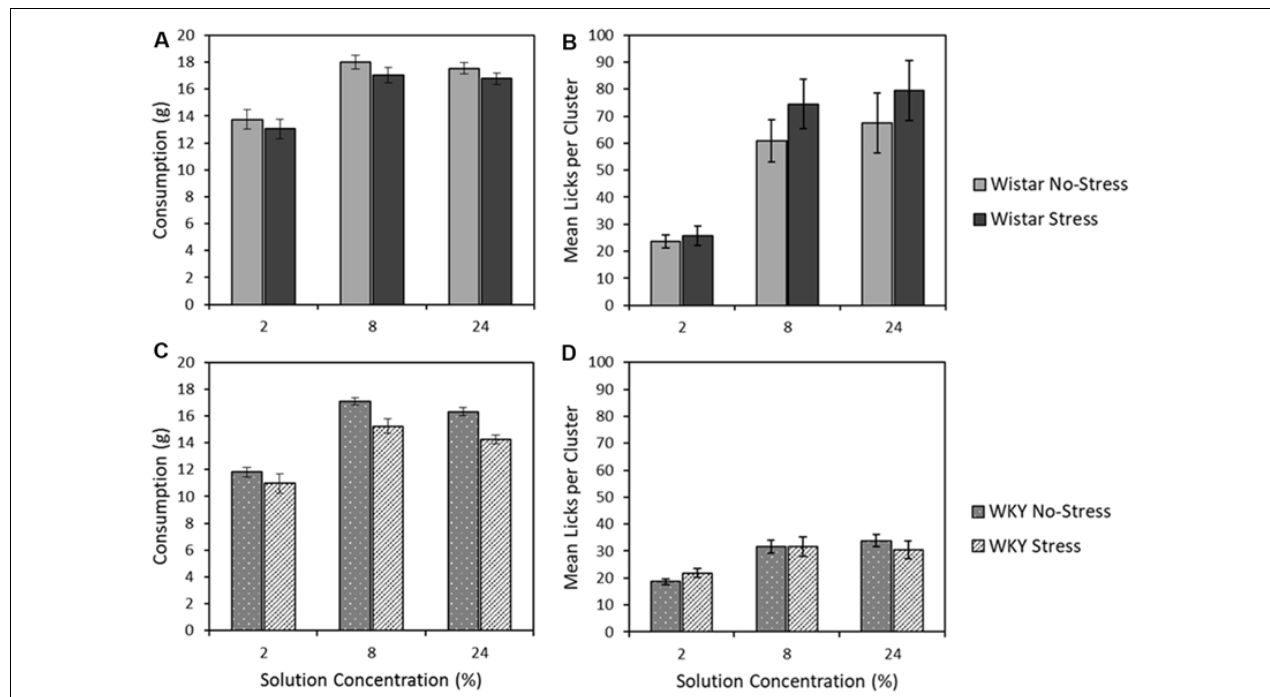
FIGURE 6 | Mean consumption ( ± SEM]; panels A,C ) and mean lick cluster size [LCS: panels B,D ( ± SEM) as a function of concentration. This test involves single solution presentations only and thereby removes the anticipatory element of the previous contrast studies. Wistar rats are shown in the upper panels (A,B) , WKY rats in the lower panels (C,D) . For consumption, WKY rats drank significantly less than Wistar rats, and stressed rats consumed significantly less than no-stress rats, but these factors did not interact (see “Consumption of 2, 8, and 32% Sucrose” section for details). While both WKY and Wistar rats displayed increasing lick cluster size with concentration increases (reflecting the higher palatability of more concentrated solutions), these effects were significantly smaller in WKY rats, which also displayed lower lick cluster size overall: a pattern of effects that is consistent with a partially preserved but extremely blunted hedonic responses in WKY rats (see “Lick Cluster Size for 2, 8, and 32% Sucrose” section for